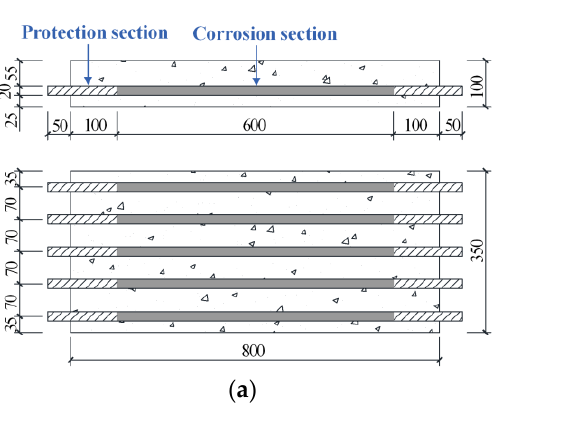
Figure 1. RC specimen design and preparation: ( a ) slab dimensions and steel rebar layout (unit: mm); ( b ) loading application. Table 2. Steel characterization of HRB400 rebars .